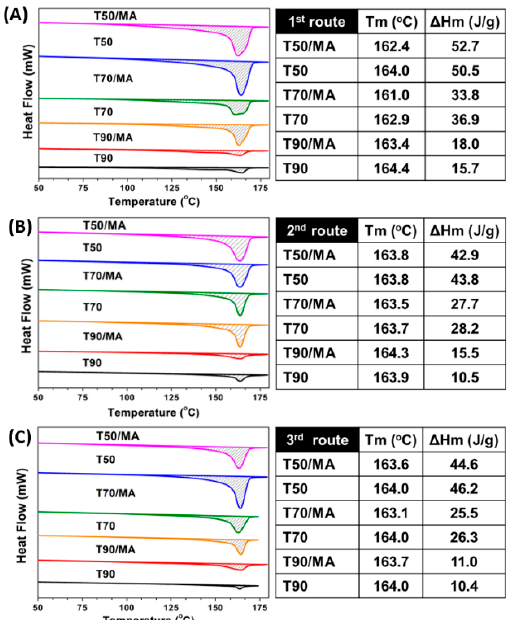
Figure 6. Melting behaviors in the di ff erential scanning calorimetry (DSC) performance of T / P and T / P / MA blends as related to melt-recycling: ( A ) one-o ff hot-pressing, ( B ) the post-2nd-recycling, and ( C ) the post-3rd-recycling. Tm = melting temperature and ∆ Hm = melting